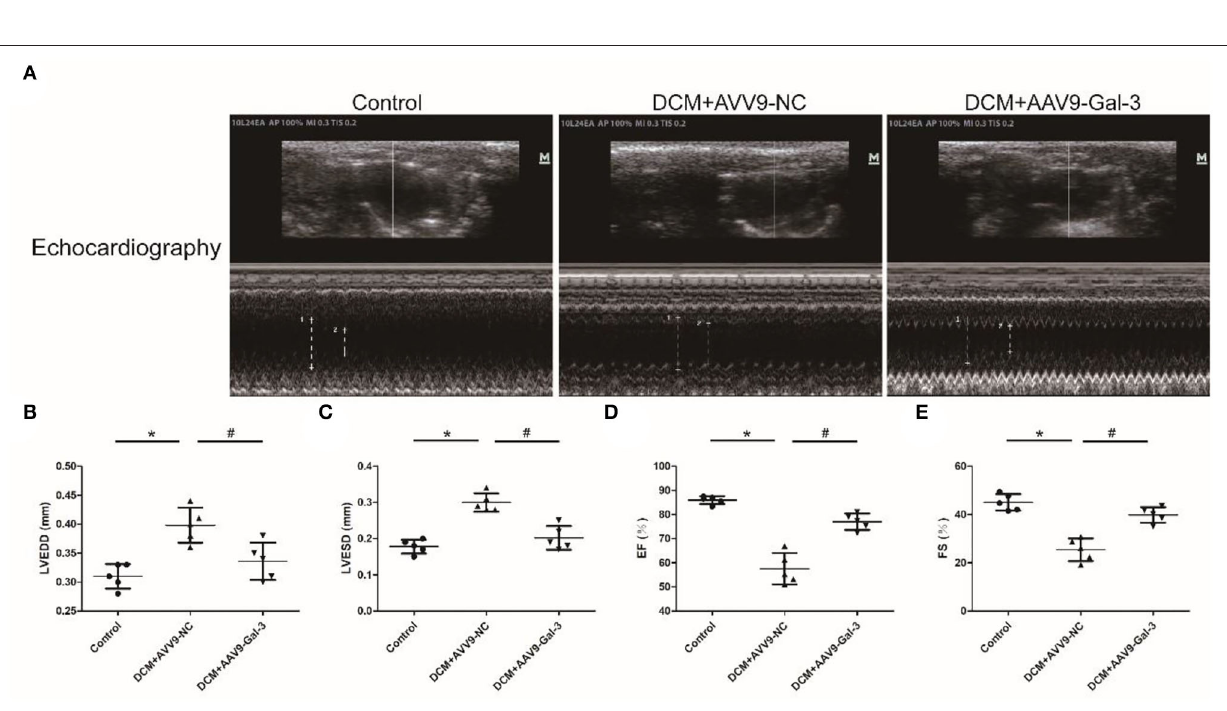
Frontiers in Cardiovascular Medicine | www.frontiersin.org 4 April 2022 | Volume 9 | Article